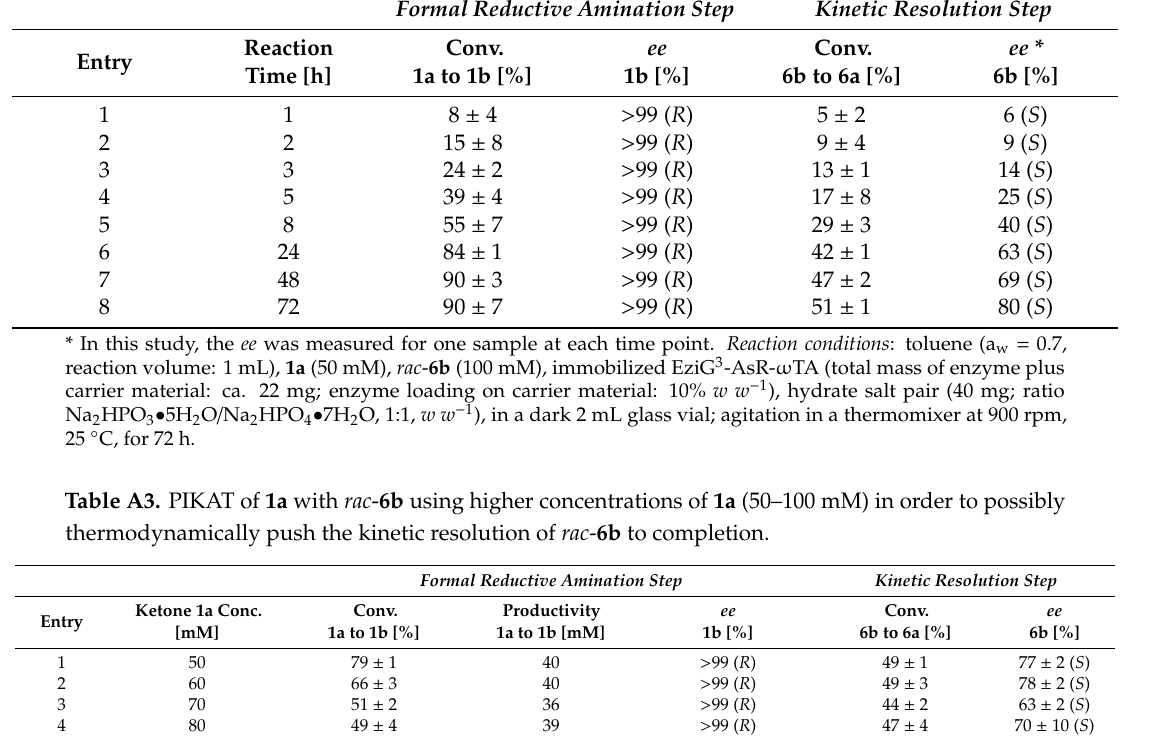
Table A2. Time study using ketone 1a and amine donor rac - 6b . Formal Reductive Amination Step